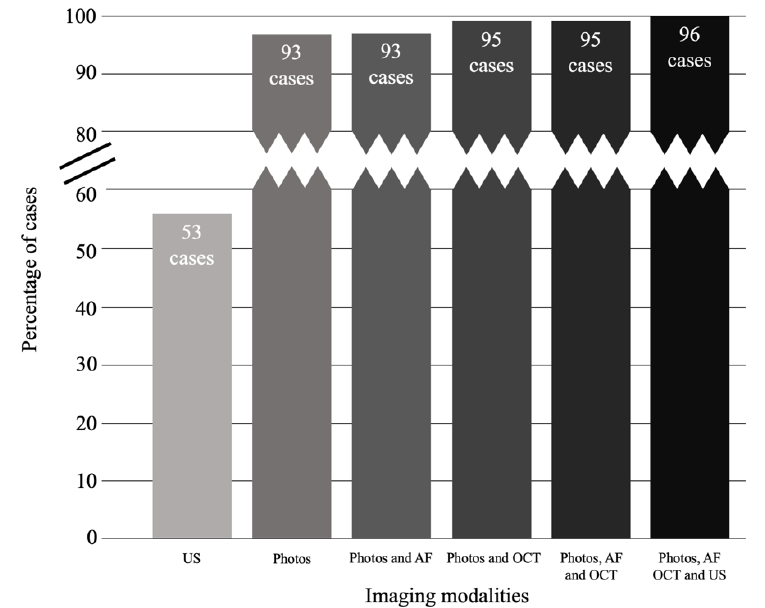
Figure 4. Progression of choroidal melanocytic tumors detected by various combinations of imaging modalities. Note: criteria for detection of progression on photos includes growth in basal dimensions and/or development of clumps of orange pigment (O = 2).